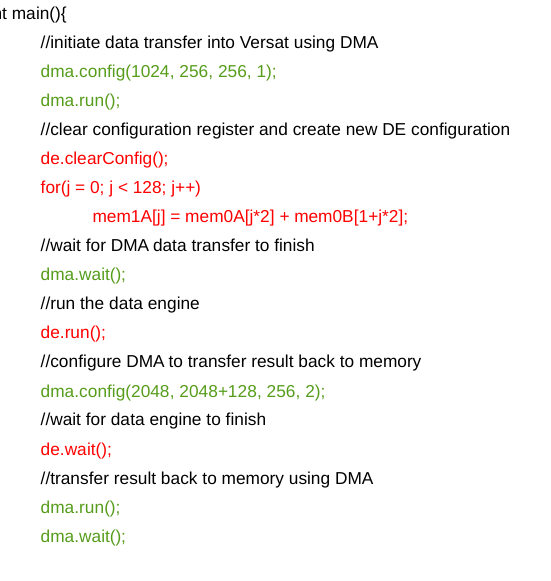
Figure 9. Vector addition